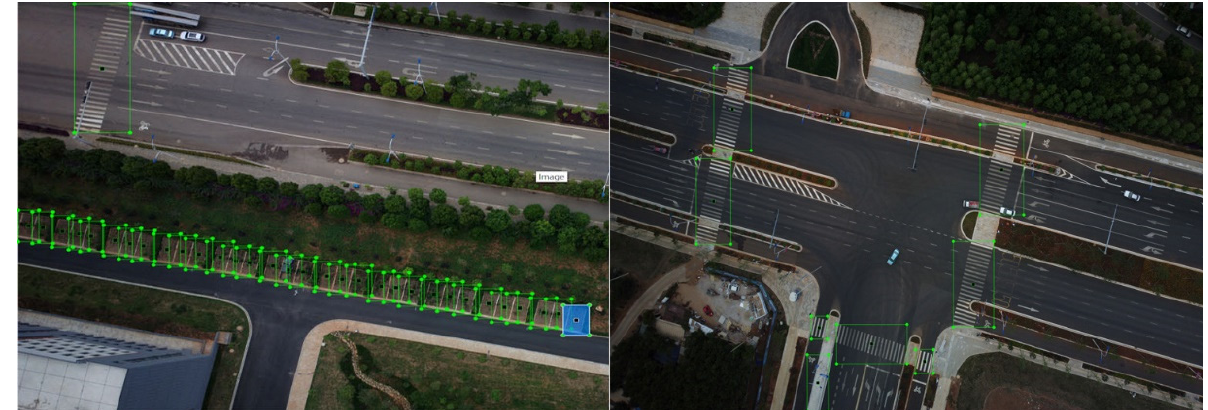
Figure 1. Sample dataset.